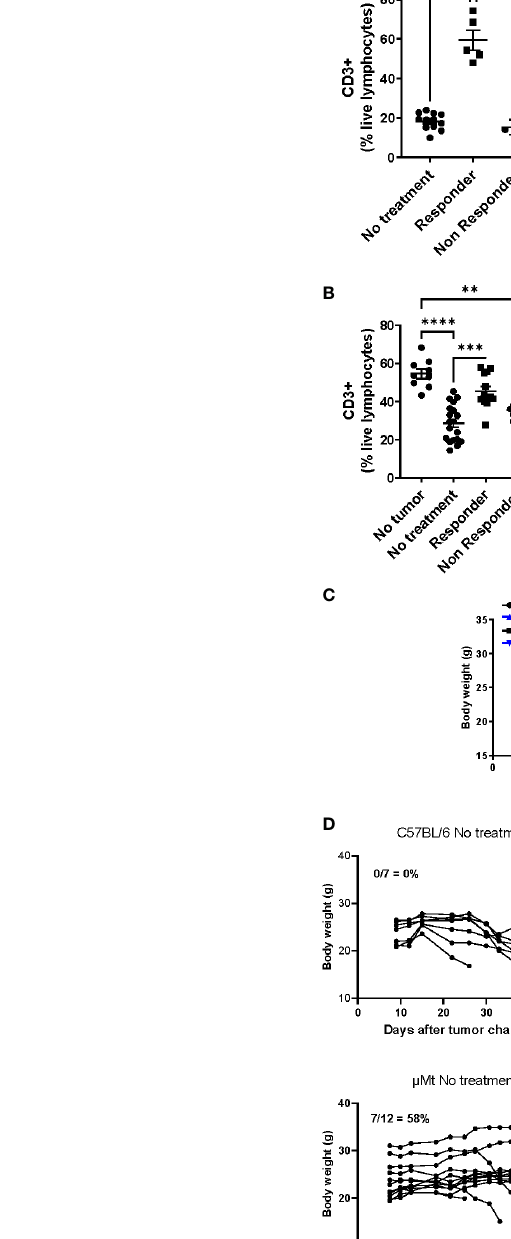
safe (29). Therefore, the role of B cells in human HNSCC may play an anti-tumorigenic role. In addition to genetic differences, humans and mice have different microbiota, which are commensal bacteria